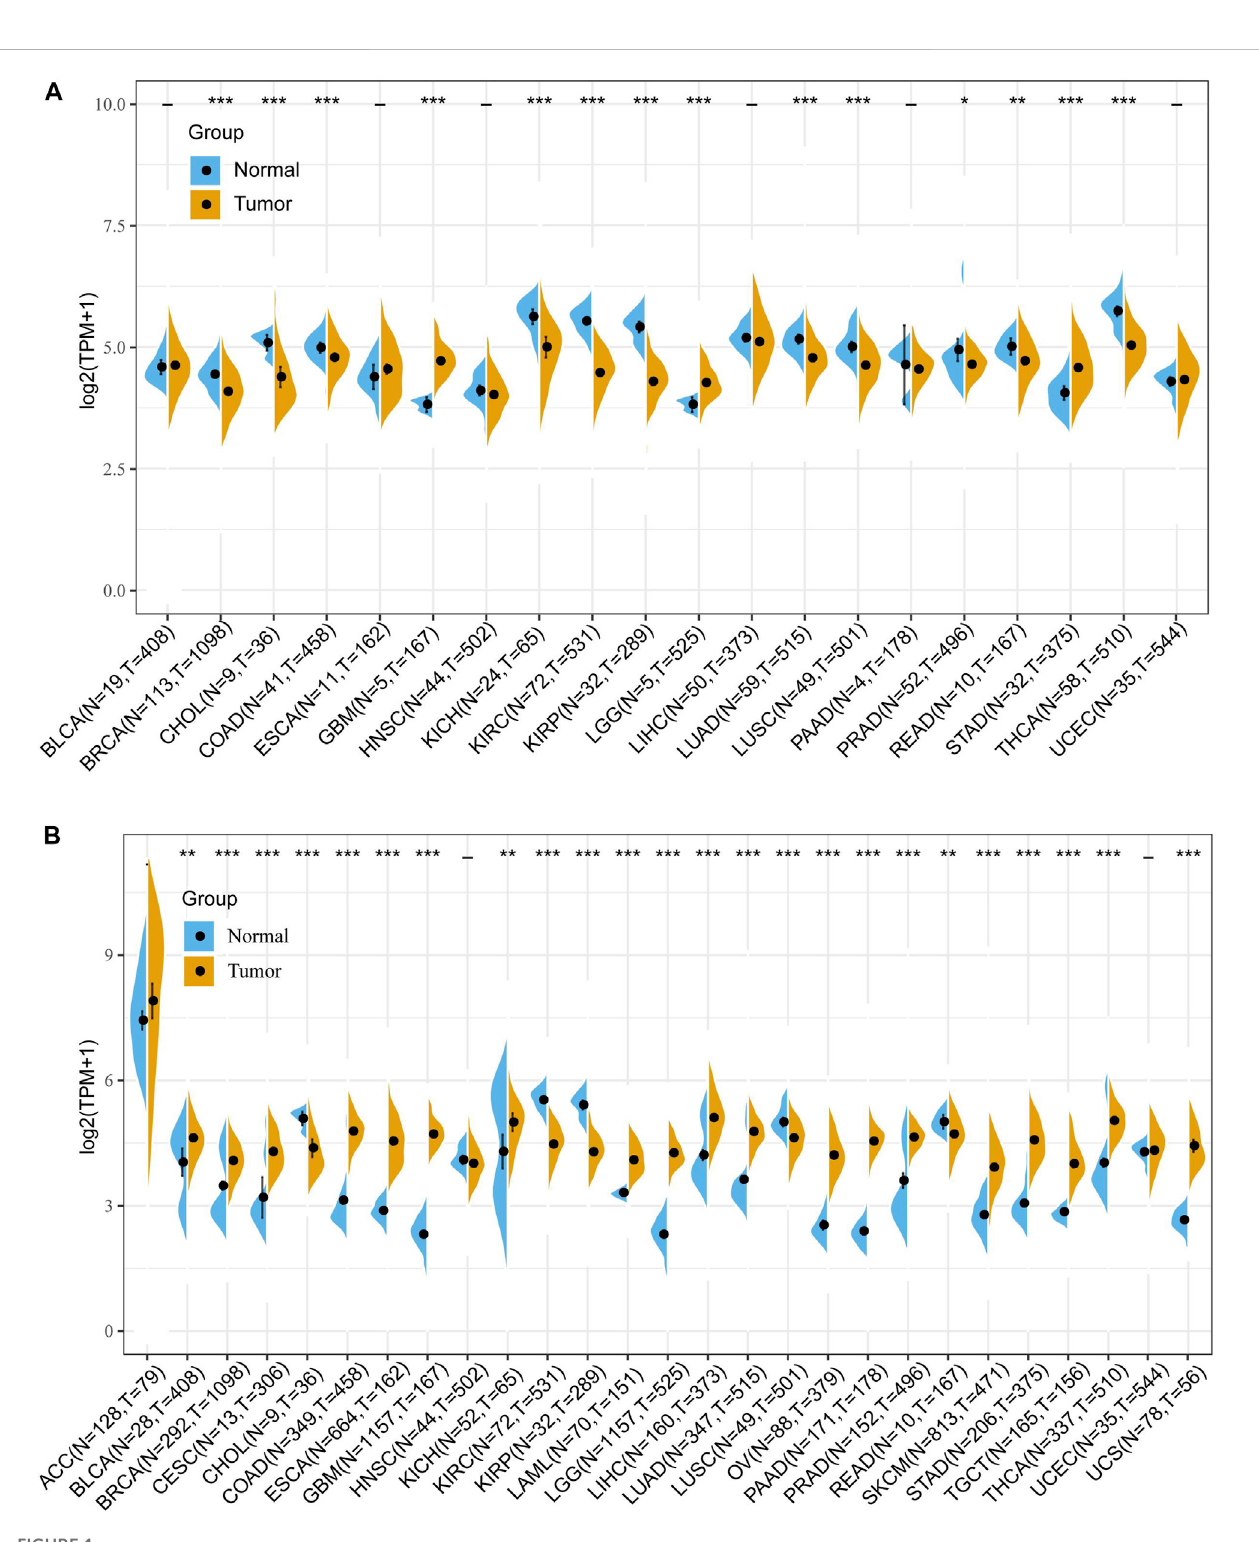
FIGURE 1 DifferentialexpressionofFDX1inhumanpan-canceraccordingtoTheCancerGenomeAtlas(TCGA)andGenotype-TissueExpression(GTEx)databases. (A) The mRNA expression of FDX1 in pan-cancer based on TCGA database. (B) The mRNA expression of FDX1 in pan-cancer based on TCGA and GTEx databases. ( t -test, p < 0.05 was considered signi fi cant, * p < 0.05, ** p < 0.01, *** p < 0.001, N, Normal tissue; T, Tumor